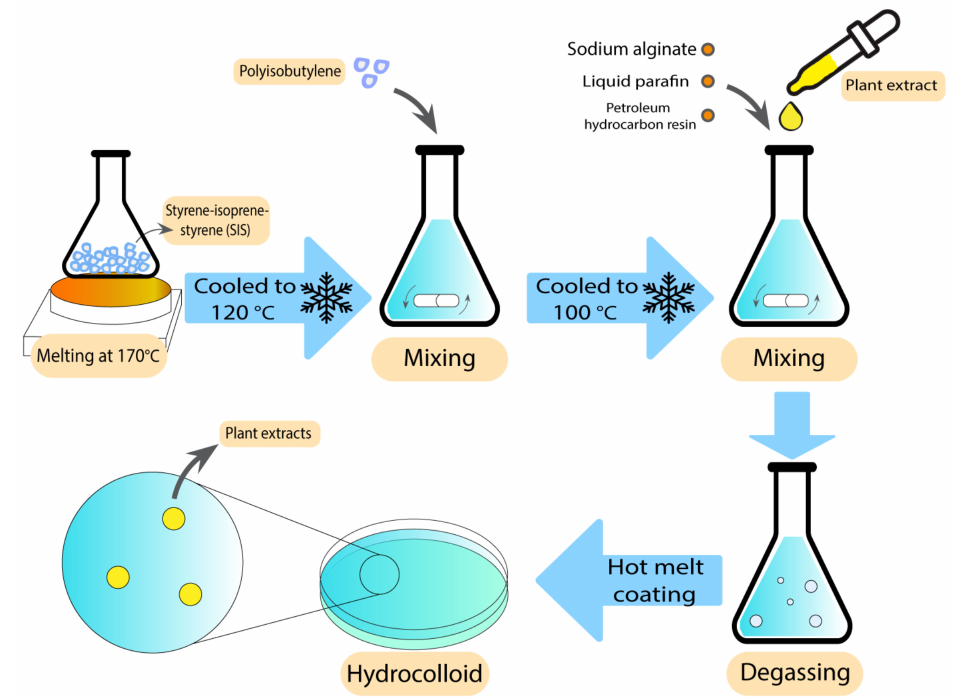
Figure 3. Preparation technique of alginate hydrocolloids using hot melt